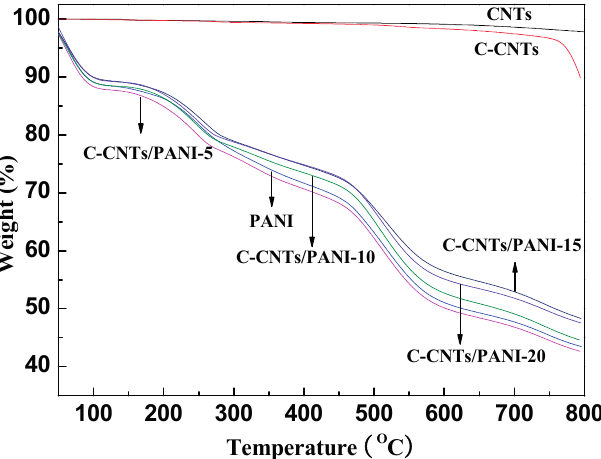
Figure 3. TGA curves of the pristine CNTs, C-CNTs, pure PANI, and C-CNTs/PANI